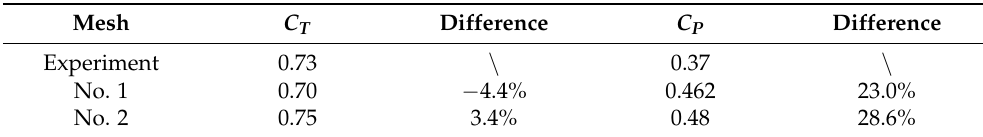
Table 6. Turbine force coefficients from [6] at TSR = 3.67 and I = 12.5% and from LBM-LES simulations at TSR = 3.67 with I = 12.5%.